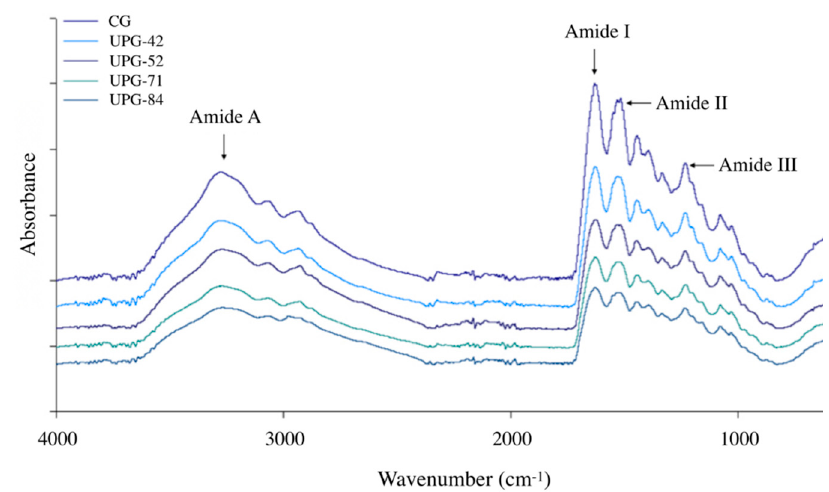
Figure 3. FTIR spectra of tilapia ( Oreochromis niloticus ) skin gelatins that were treated with high intensity ultrasound pulses.